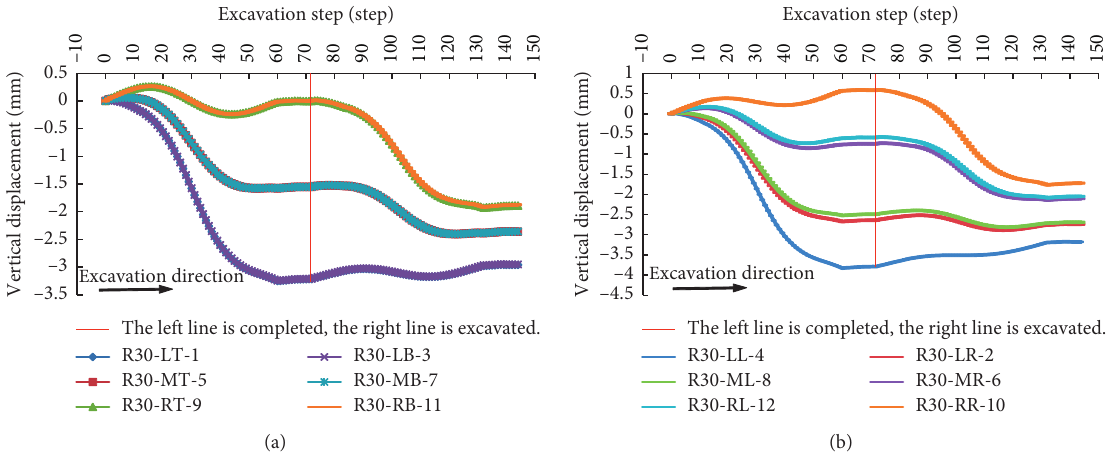
Figure 13: The vertical displacement curves of each monitoring point during construction: (a) pipe gallery top and bottom; (b) pipe gallery